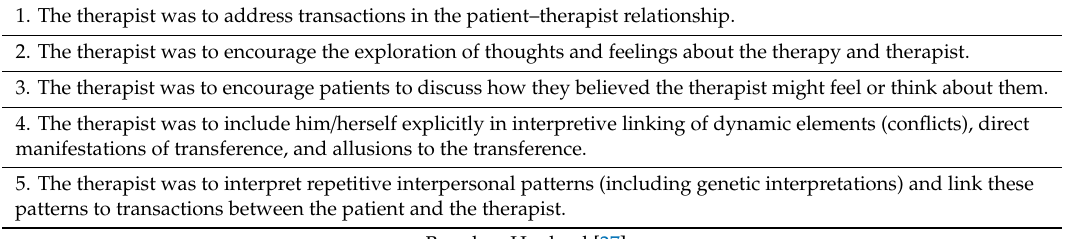
Table 1. The five categories of transference work (TW) defined in the First Experimental Study of Transference interpretations